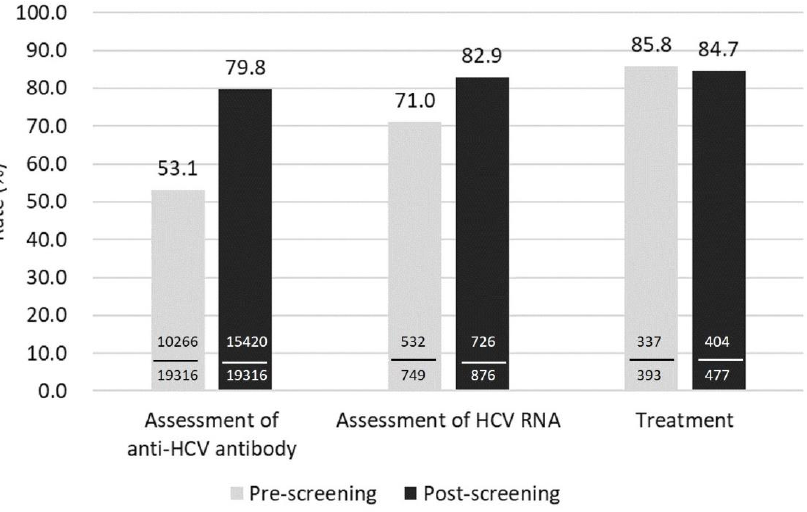
Figure 2. The rates of the assessment of anti-HCV antibody, HCV RNA, and treatment in the pre-screening and post-screening periods.